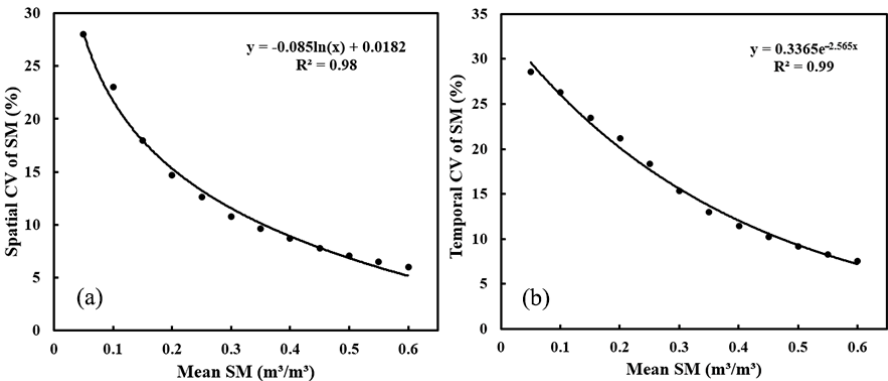
Figure 11. The corresponding CV for each mean SM interval. ( a ): Spatial; ( b ): Temporal.